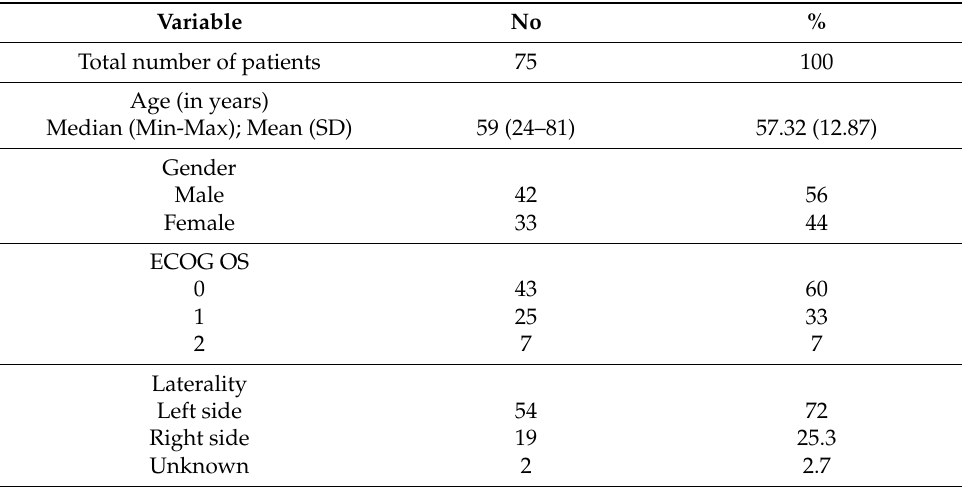
Table 1. Clinicopathological